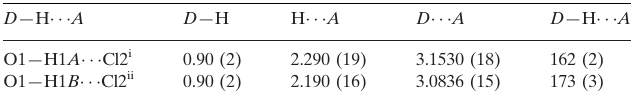
Hydrogen-bond geometry (A˚ , (cid:3)